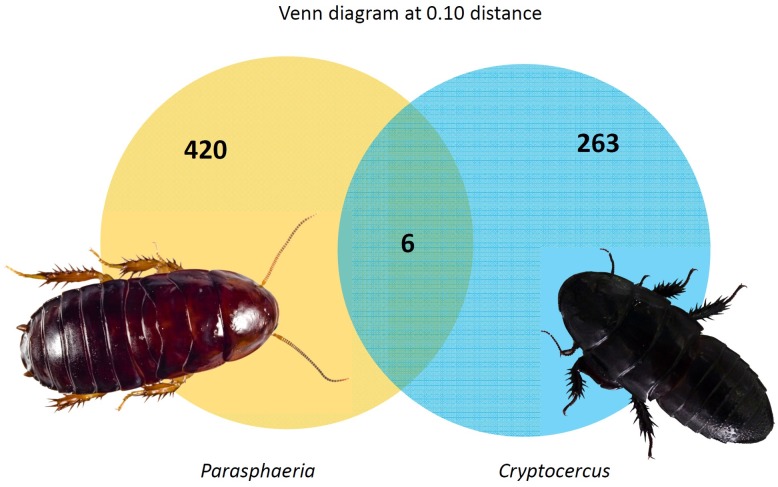
Venn diagram.Parasphaeria and Cryptocercus shared 6 OUT at 0.10 distances. Figure showed the two cockroaches. (Photo by M. Berlanga and R. Duro).